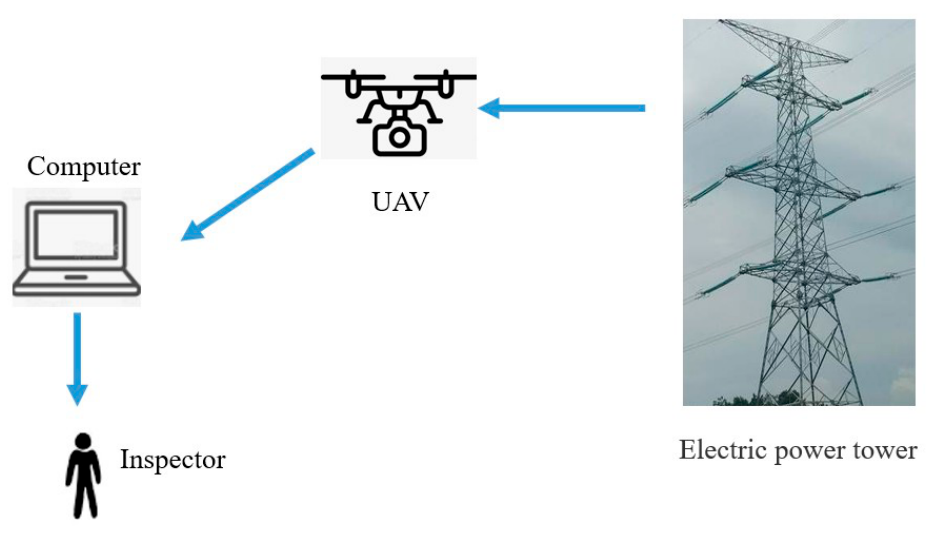
Figure 6. Offline detection. Figure 6. O ffl ine detection.